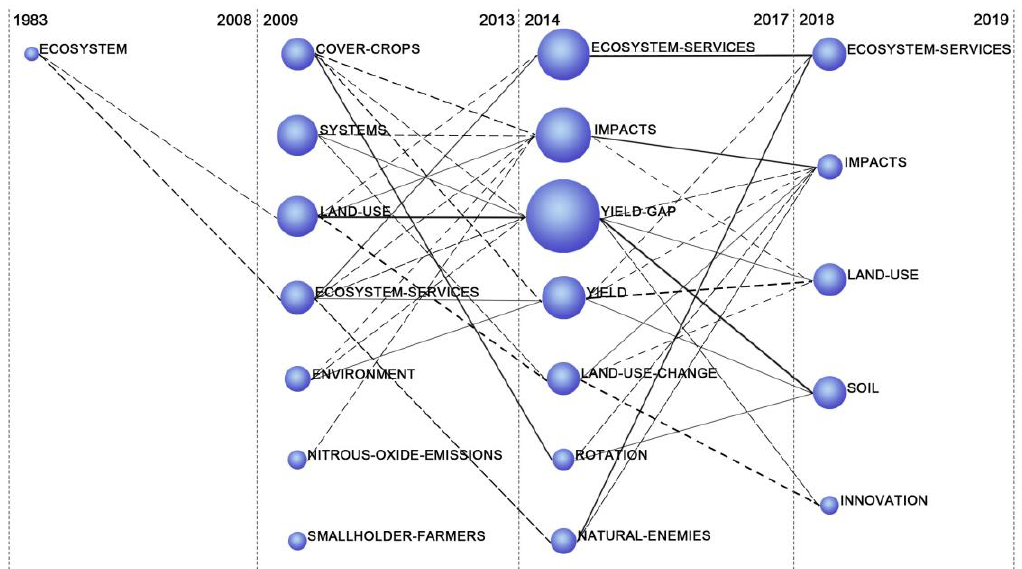
Figure 1. Thematic evolution of the agricultural sustainable intensification research field (1980–2019). Data Source: Web of Science Core Collection.